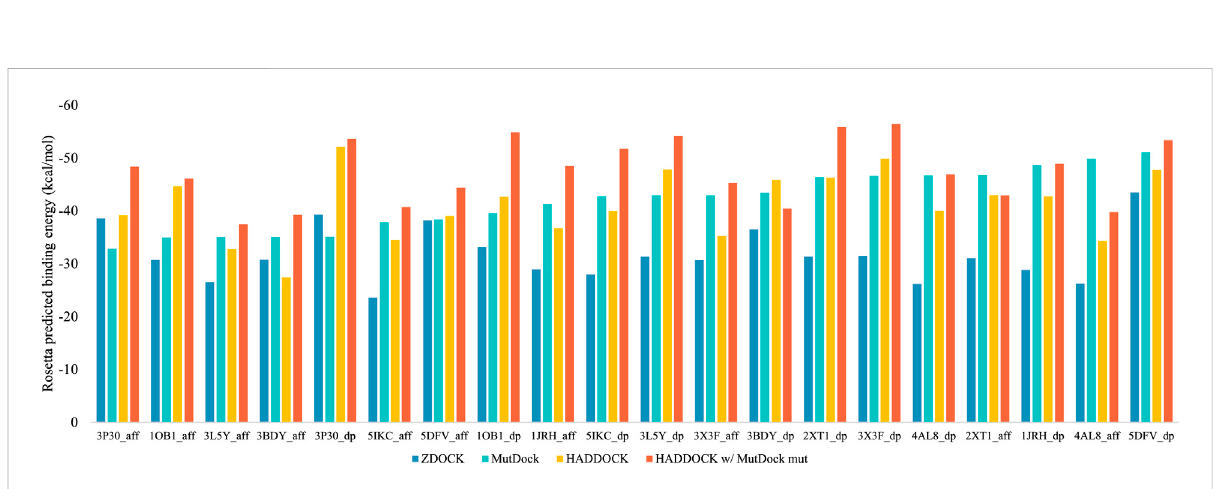
FIGURE 6 Top Rosetta-predicted computational binding energies of poses from the 20 docking simulations performed using ZDOCK, MutDock, HADDOCK, and a combination approach of HADDOCK with top MutDock scaffold.